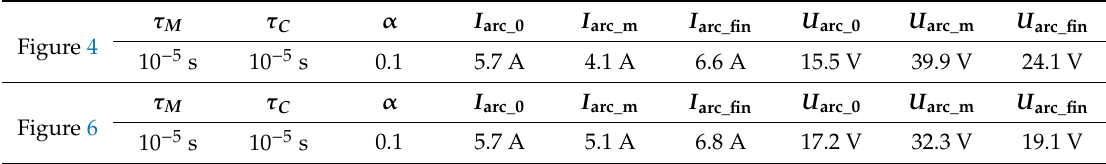
Table 3. Habedank arc model parameters setting.